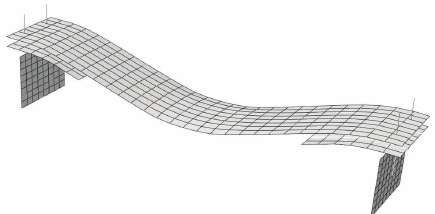
Figure 9: Finite element model of test bridge.